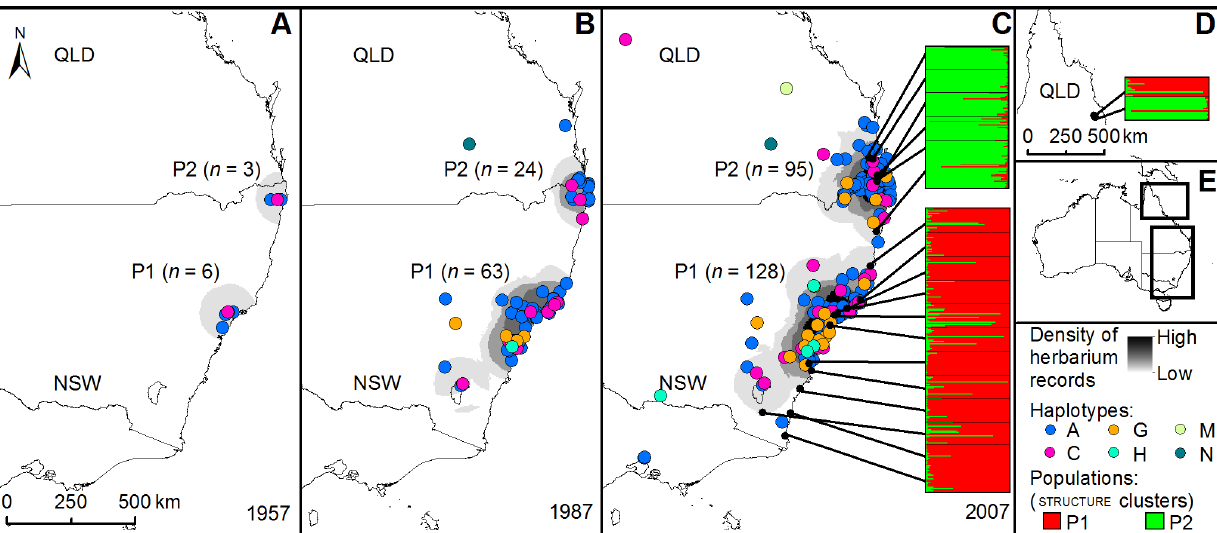
Figure 3. Maps illustrating the spread of Senecio madagascariensis in Australia through time. Density of herbarium records and location of chloroplast haplotypes (A-C); location of P1 and P2 derived from nuclear microsatellite data from contemporary field collections (as defined by clusters in the program STRUCTURE [44]) (C, D); clustering of sites in Far North Queensland with P1 and P2 (D); extent of maps in relation to Australia as a whole (E).